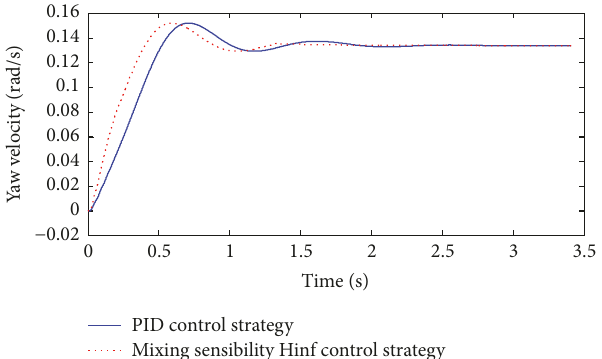
Figure 7: Comparison of step response of yaw